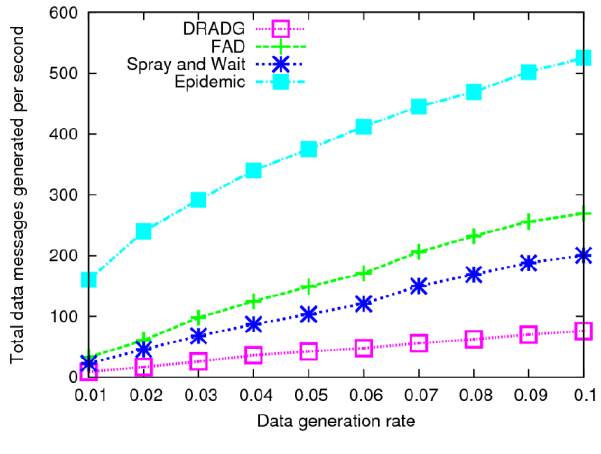
Figure 6. The number of data messages generated per second.